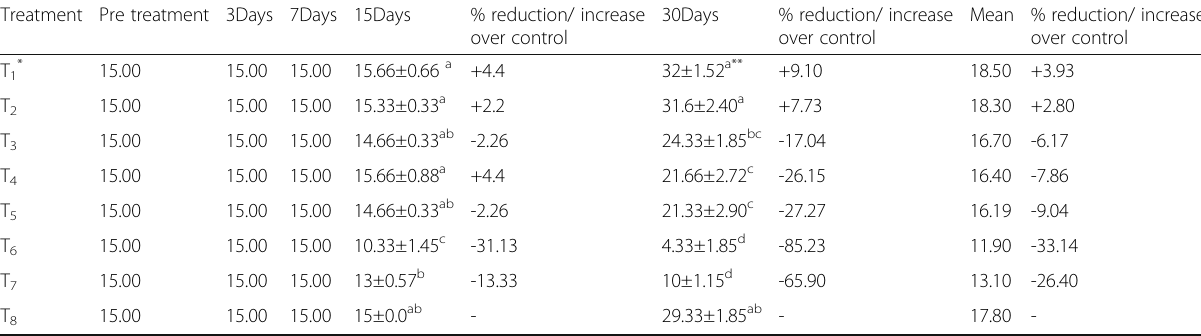
Table 6 Effect of insecticides on Earthworm ( Eisenia fetida L.) at different intervals Treatment Pre treatment 3Days 7Days